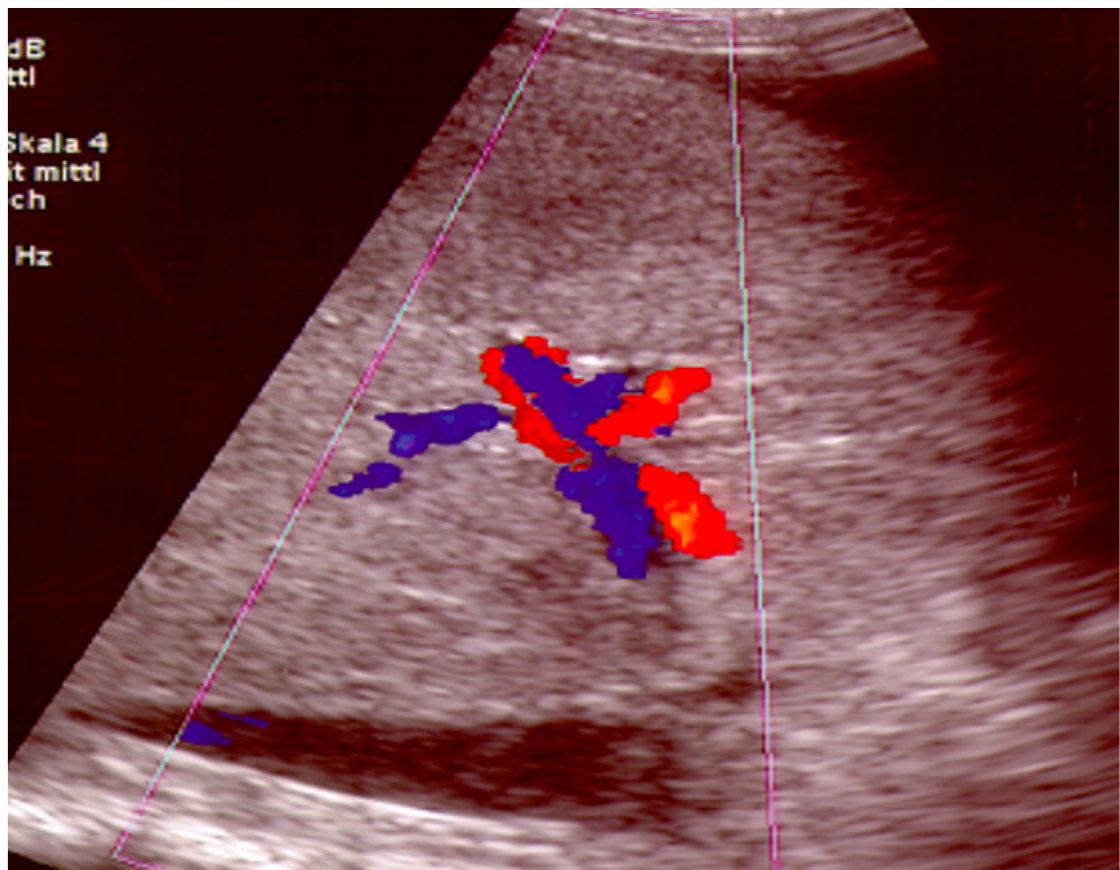
Figure 7. Intrahepatic portal flow (blue) in a patient with BCS after TIPS implantation. Hepatic artery in red.